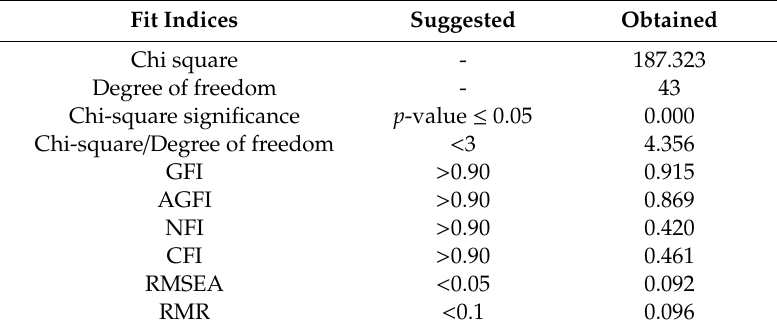
Table 21. Fit indices and their acceptable thresholds in